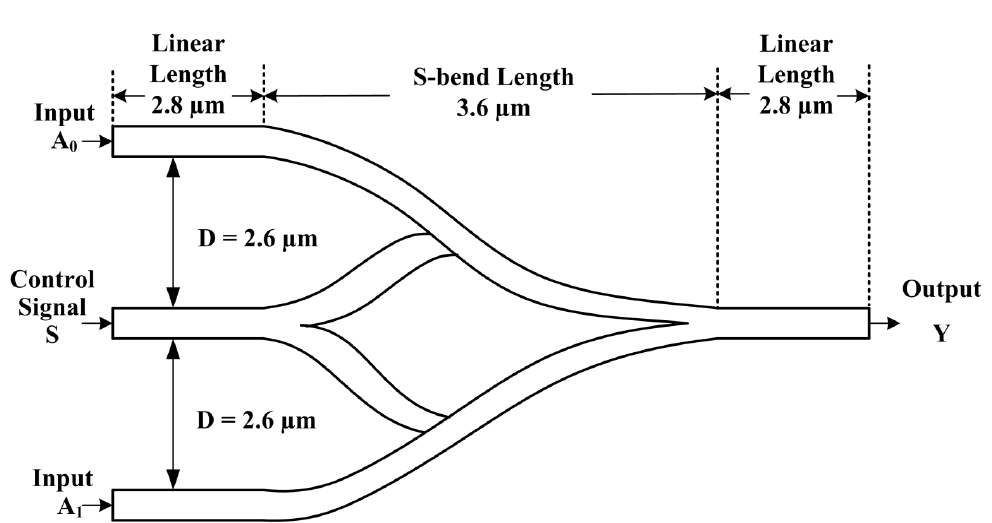
Figure 1. Schematic of the proposed 2 × 1 multiplexer. Table 2. Simulation parameters of proposed 2 × 1